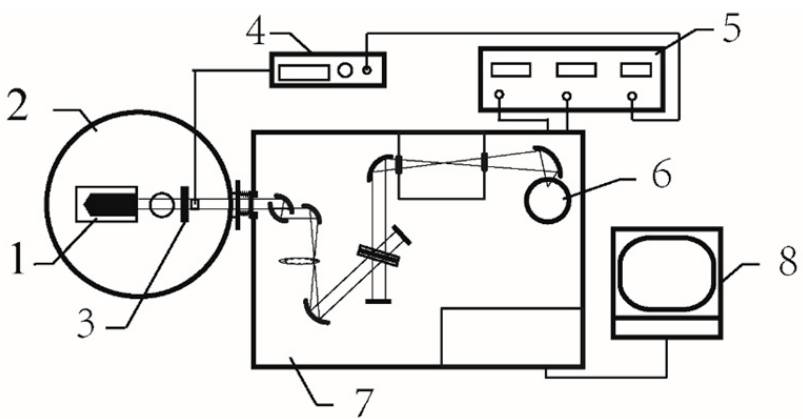
Figure 1. Schematic diagram of the measurement apparatus. 1—sample holder, 2—sample cooling chamber, 3—chopper wheel, 4—chopper controller, 5—lock-in amplifier, 6—mercury cadmium telluride detector, 7—Fourier transform infrared spectrometer, 8—computer.